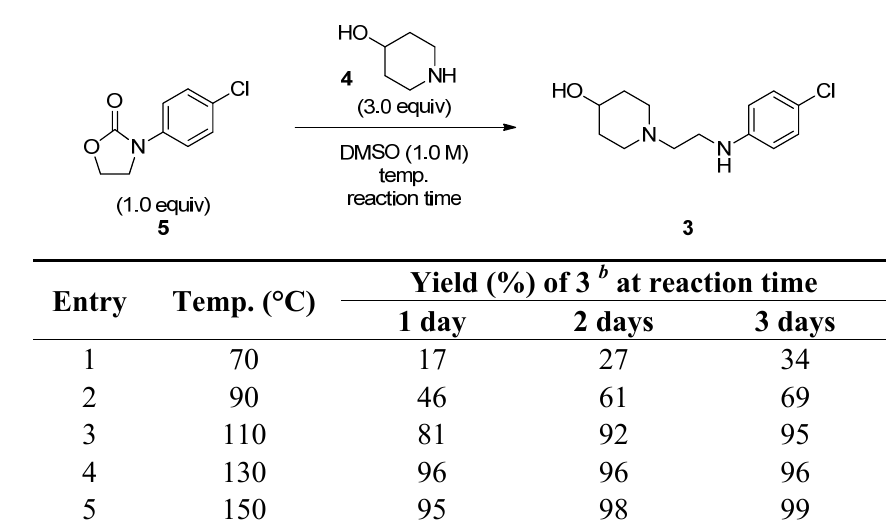
Table 1. Optimization of reaction conditions a .